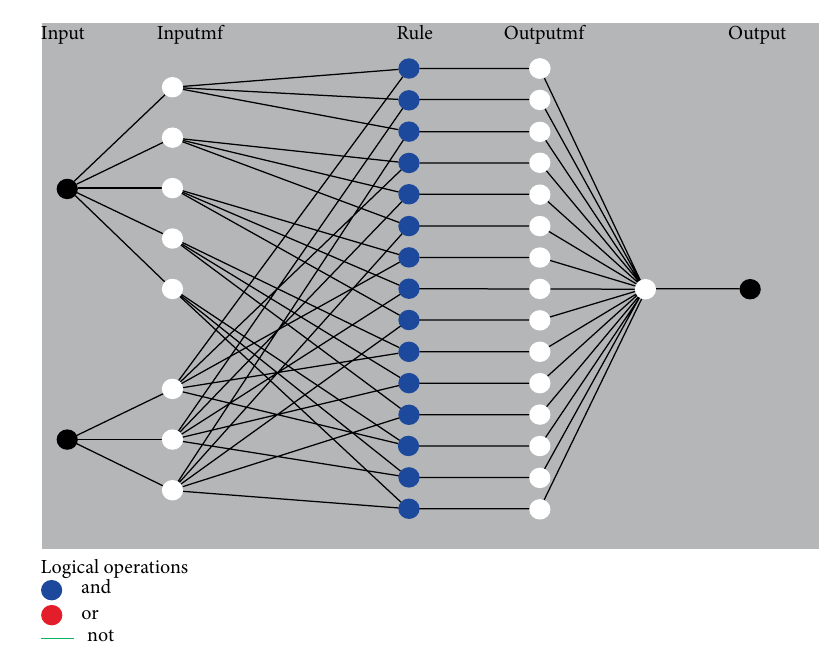
Figure 4: ANFIS model